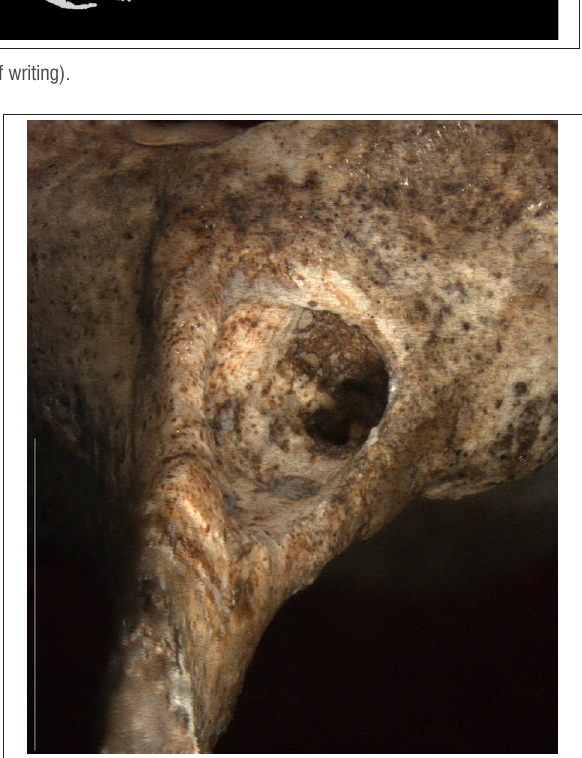
Figure 3: Vertebra U.W. 88-37. Multi-focus (composite image stack) micrograph of surface morphology of U.W. 88-37 showing sub-angular penetrating defect on the right vertebral lamina. The lesion has well-rounded edges with lateral bulging of the cortex over the lesion, indicating a reactive remodelling response to the presence of the defect. Note that anterior portion of defect remains infilled with breccia matrix. Micrograph taken with Olympus SZX Multi-focus microscope, magnification 7x. Scale bar = 10 mm. Image courtesy of Alexander Parkinson.